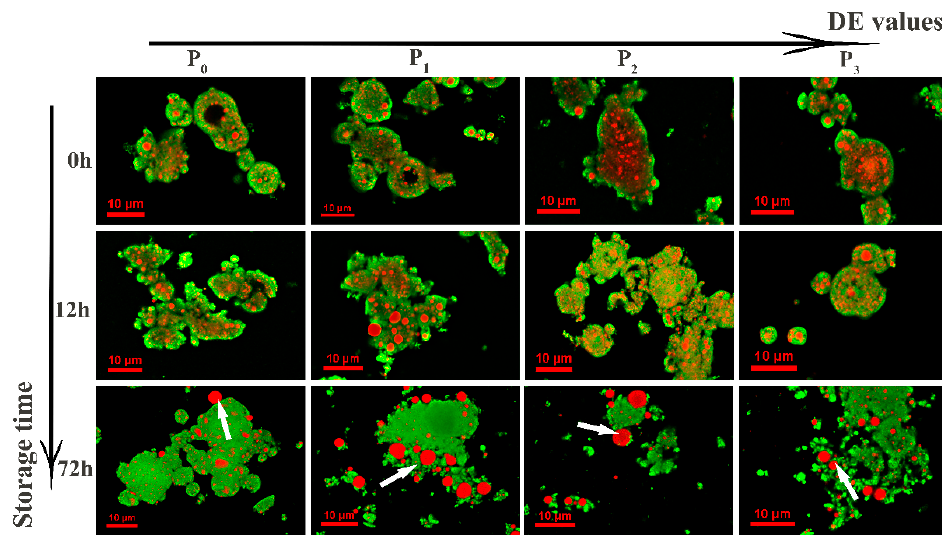
Figure 7. Confocal laser scanning microscopy confocal laser scanning microscopy images of powdered microcapsules after storage at 75% RH for 0 h, 12 h and 72 h. The DE values means dextrose equivalent (DE) values.